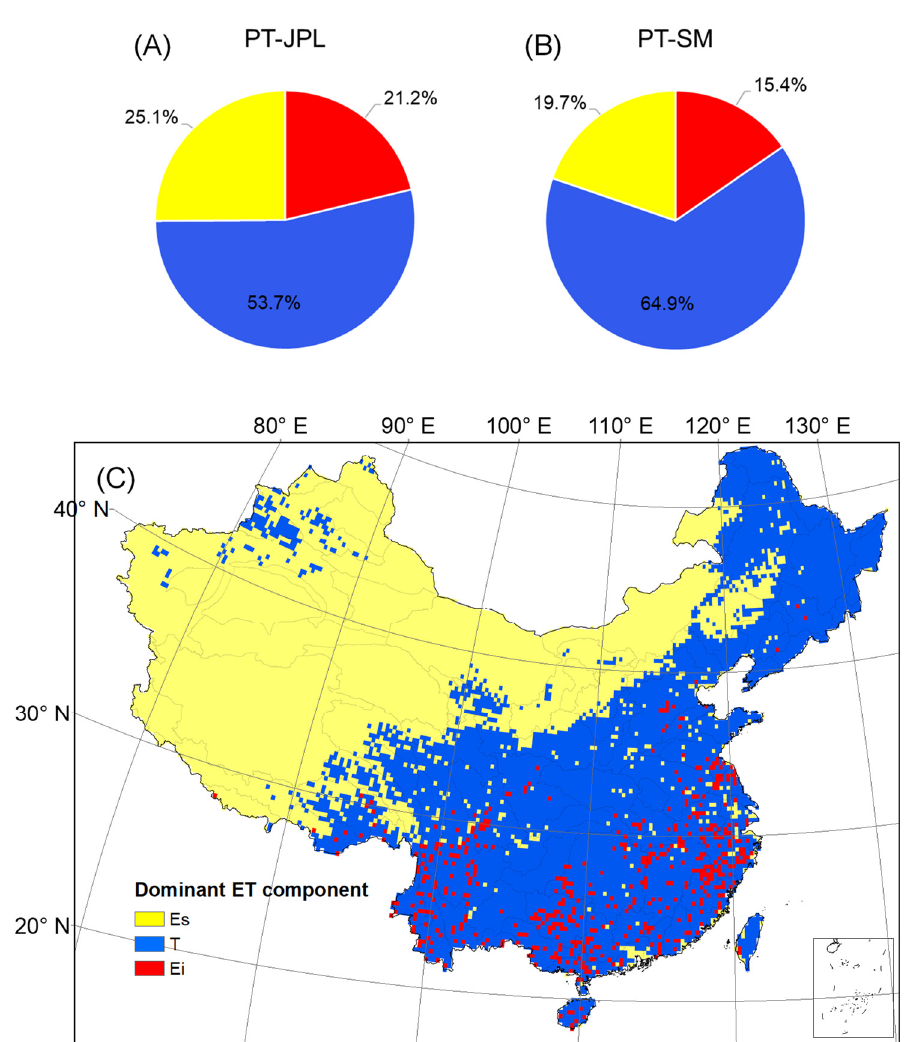
Figure 11. Evapotranspiration ( ET ) components expressed as a percentage of total ET from ( A ) the original PT–JPL algorithm (PT–JPL) and ( B ) updated PT–SM algorithm across China. Yellow indicates soil evaporation ( E s ), blue indicates vegetation transpiration ( T ), and red indicates canopy interception evaporation ( E i ). Below, ( C ) the spatial distribution of the dominant percent contribution to total ET from components as E s , T , and E i .